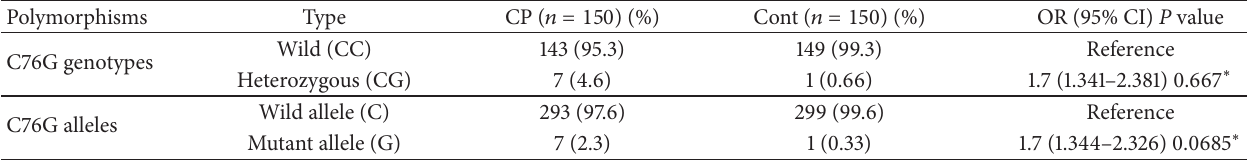
Table 5: Genotype and allele frequency of C76G